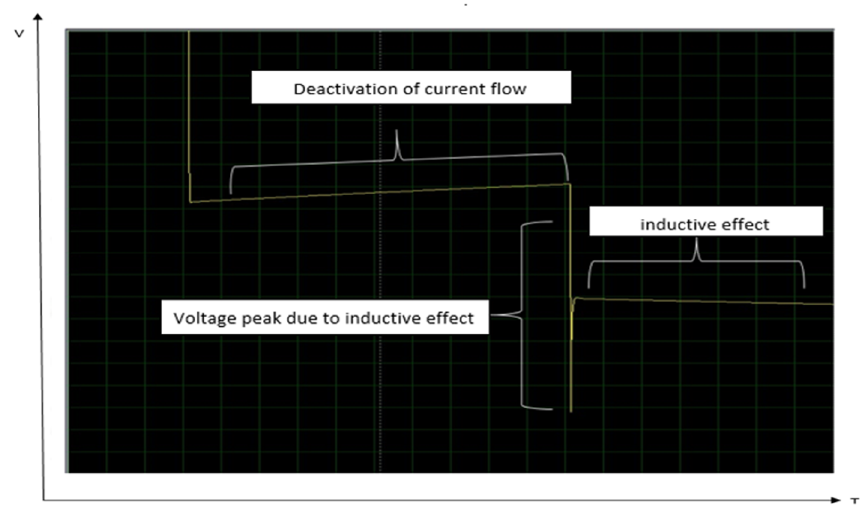
Figure 10. Peak voltage due to inductive effect of motor.